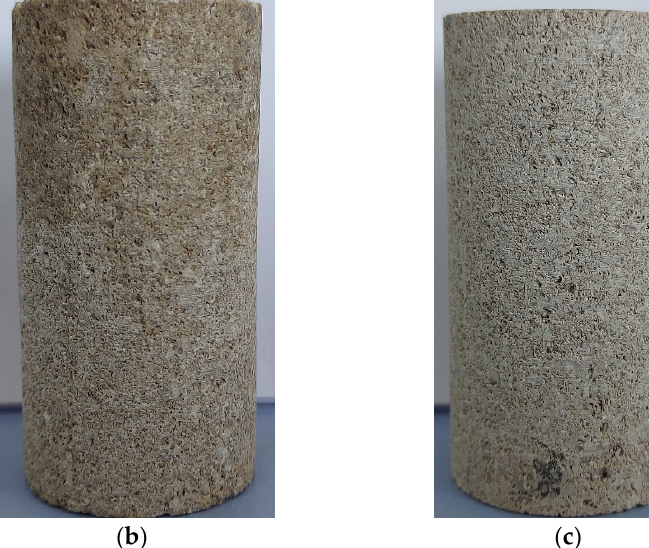
Figure 8. Used core samples from ( a ) CF-1, ( b ) CF-2, and ( c ) CF-3.